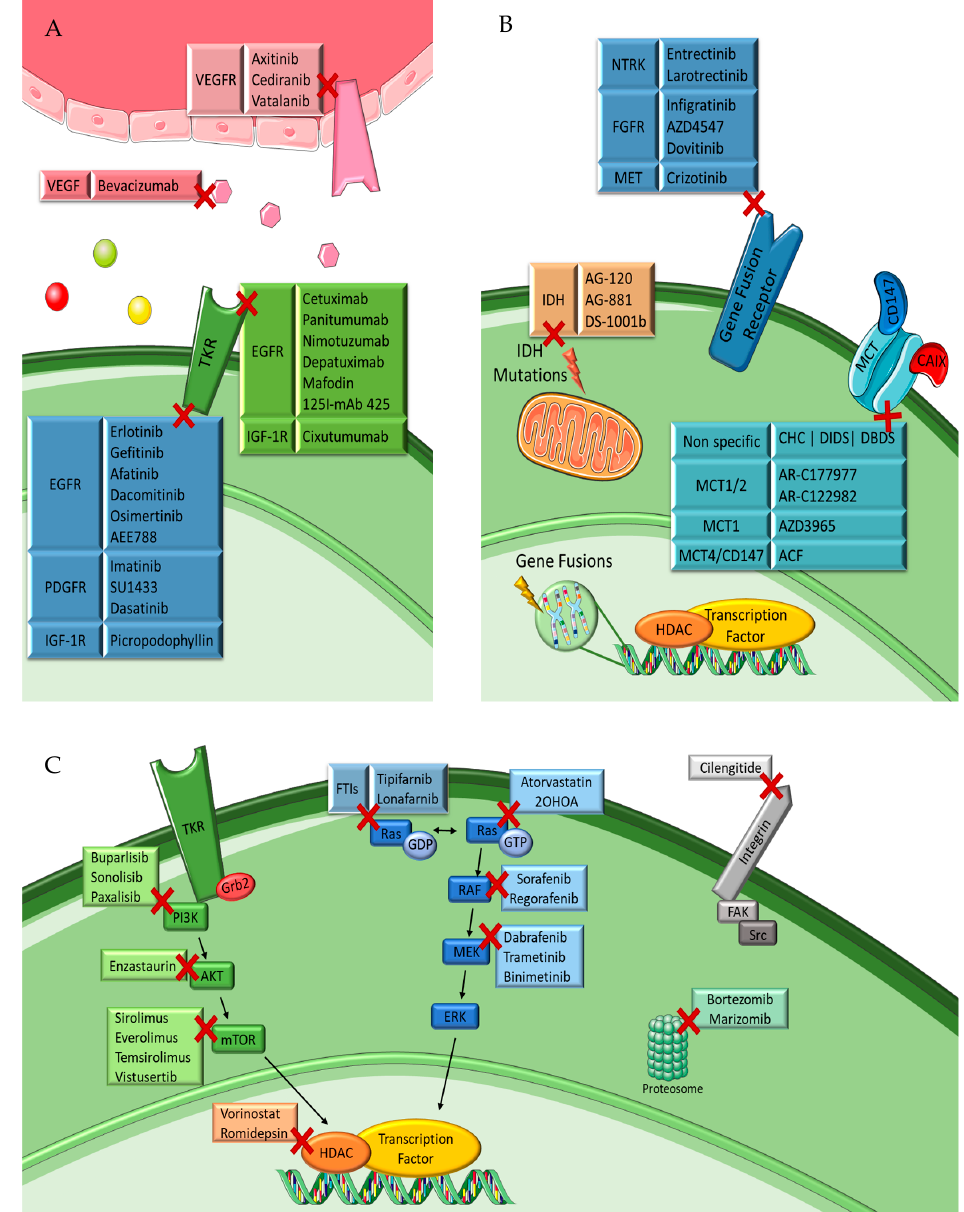
Figure 5. Targeted therapies for malignant glioma. Simplified representation of ( A ) tyrosine kinase receptor inhibitors, ( B ) IDH, gene fusion and MCT inhibitors and ( C ) specific inhibitors of intracellular downstream pathways. Figure drawn with smart.servier.com.